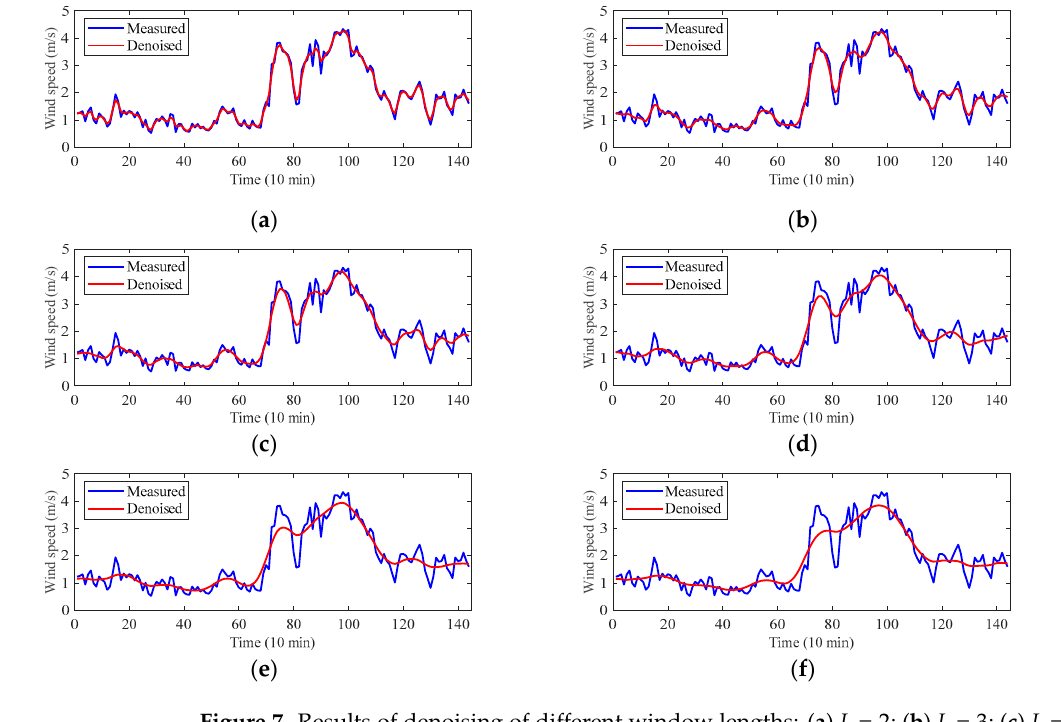
Figure 7. Results of denoising of different window lengths: ( a ) L = 2; ( b ) L = 3; ( c ) L = 4; ( d ) L = 6; ( e ) L = 8; ( f ) L = 10.